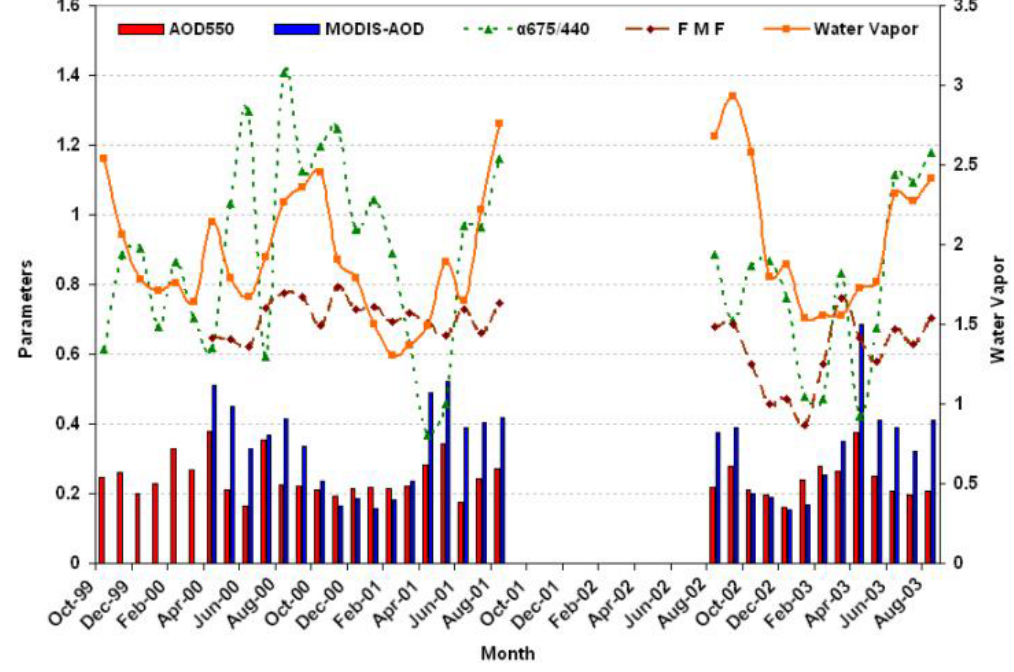
Fig. 2. Microtops II monthly mean AOD at (550nm), precipitable water vapor and ˚Angstr¨om exponent ( α 675/440) with corresponding monthly means of MODIS-AOD and FMF over Alexandria for two time periods from October 1999 to August 2001 and from August 2002 to August